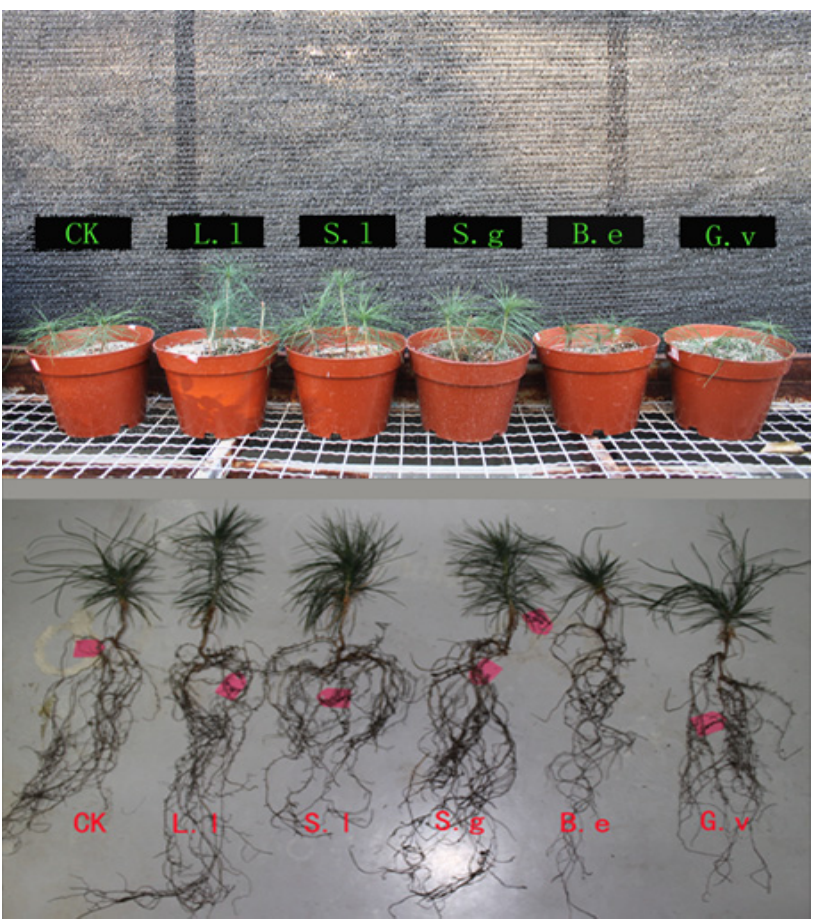
Figure 3. Growth of Pinus tabulaeformis seedlings inoculated with L. laccata (L.l), S. luteus (S.l), S. grevillei (S.g), B. edulis (B.e), G. viscidus (G.v), and non-mycorrhizal (CK); above (above-ground growth)